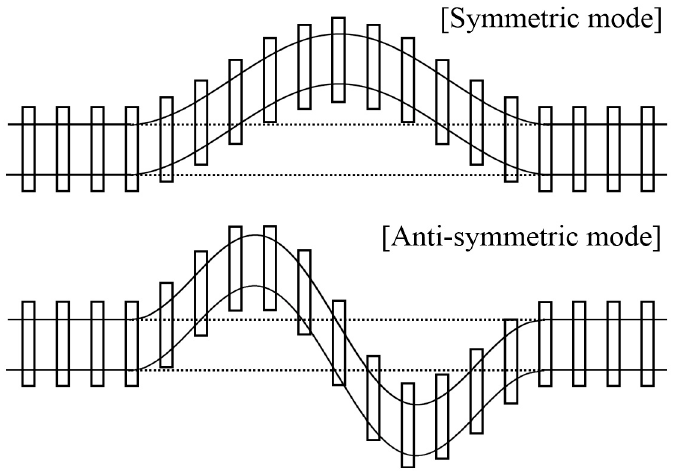
Figure 5. Track buckling shape.